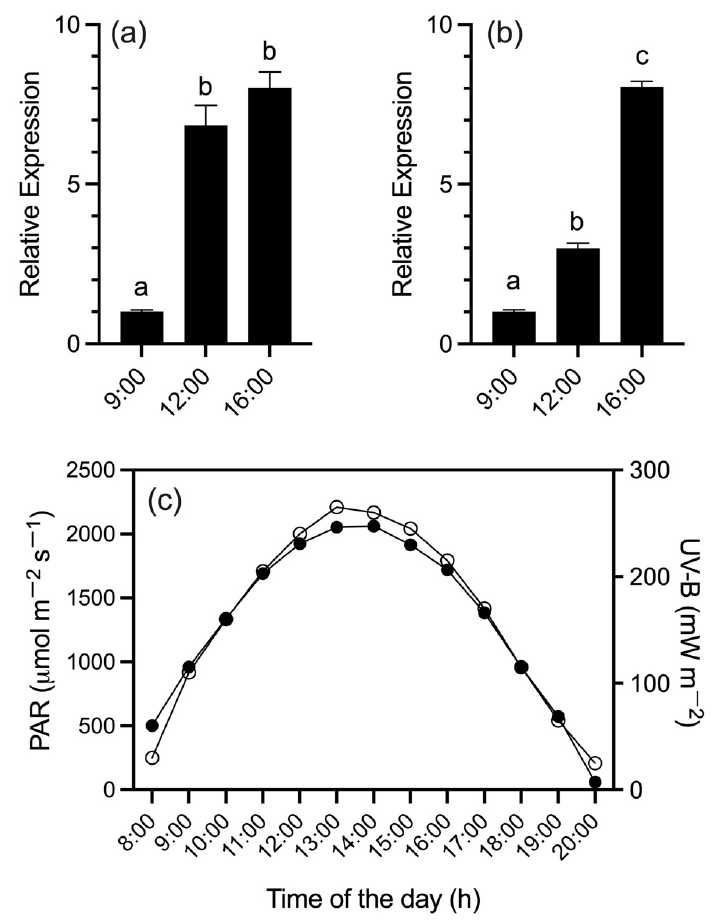
Figure 4. Relative expression levels of ( a ) SpAN2 and ( b ) SpDFR genes in the fruit peel of Solanum peruvianum accession QUI958 under sunlight radiation. The expression of each gene was measured at 9:00, 12:00, and 16:00 h. Error bars in each column represent the standard deviation of three replicates. For both genes, Tukey’s multiple comparisons test was performed with 95% confidence. Different letters indicate significant differences between means. ( c ) The radiation index for UV-B ( µ W m − 2 ) (white circles) and PAR ( µ mol m − 2 s − 1 ) (black circles) for the fruit sampling day (15 January 2020) is shown. For details see the Section 2.